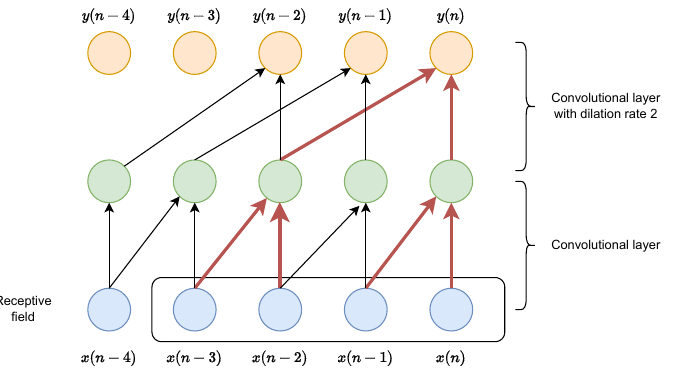
Figure 4. A schematic illustration of time dependence for a composition of two layers convolutional and convolutional with dilation rate of